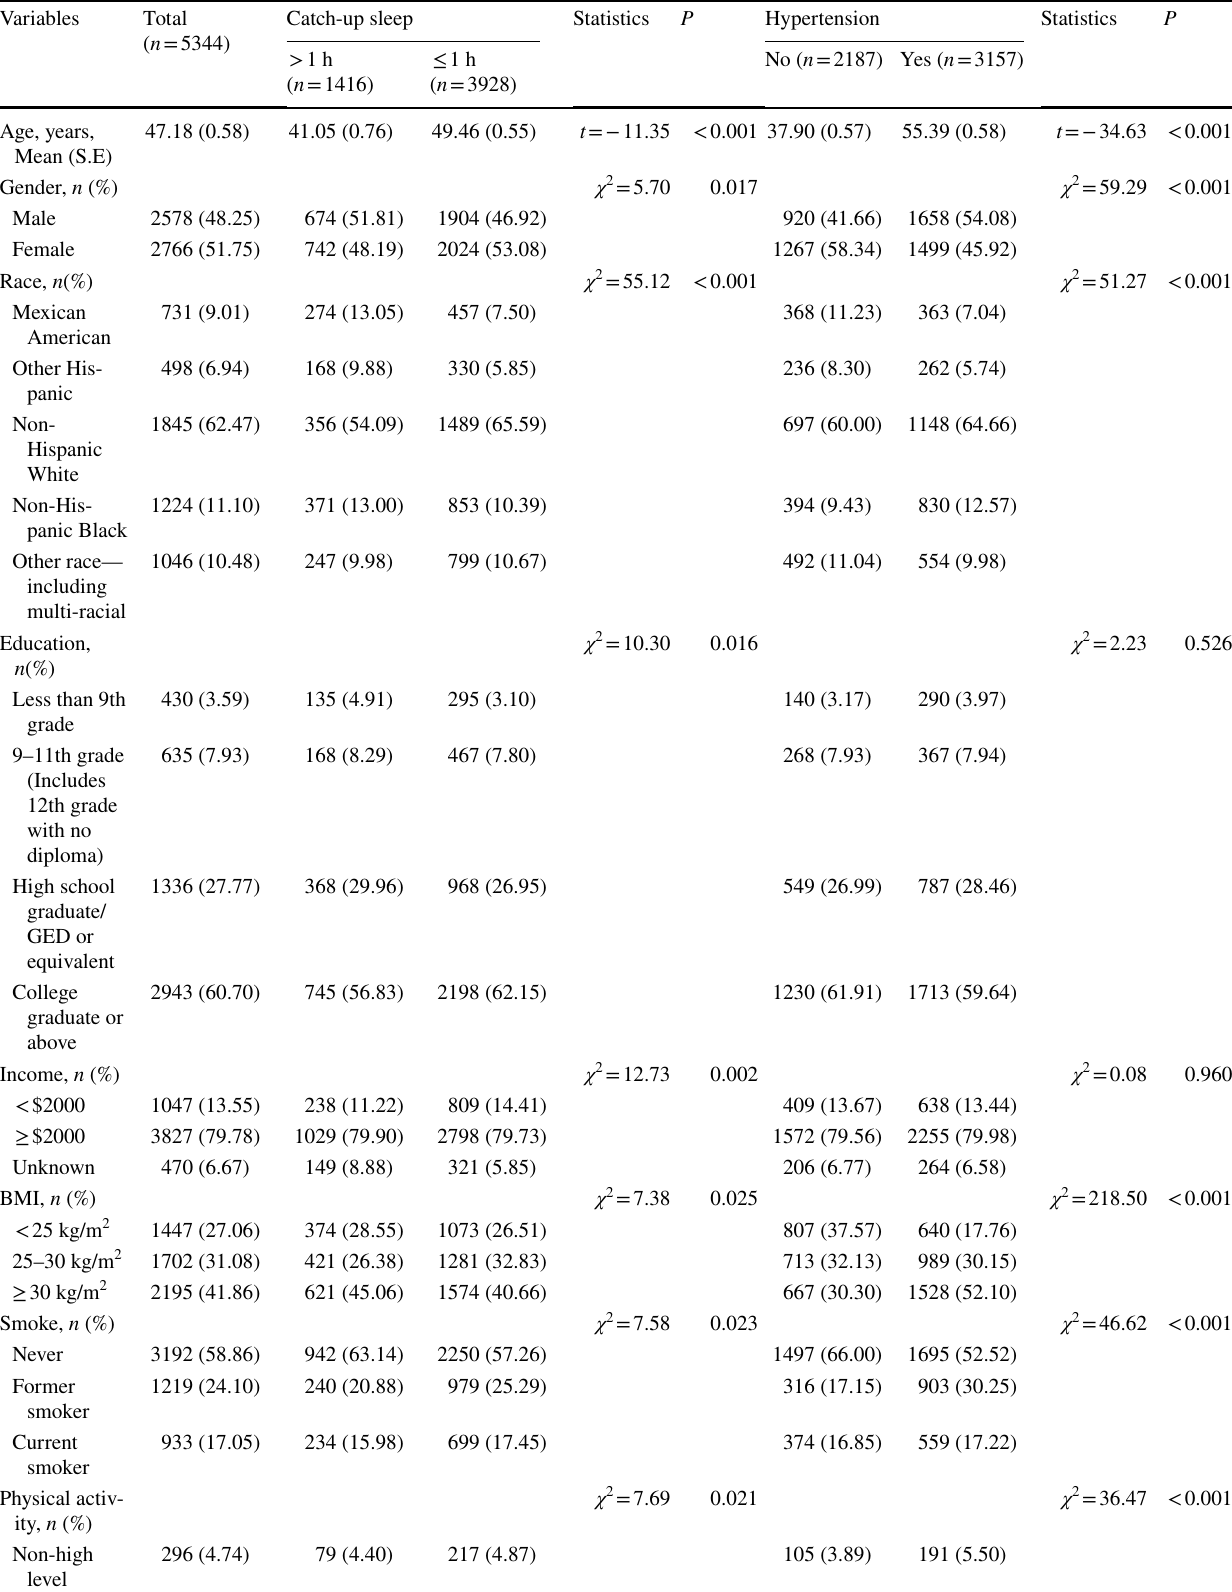
Table 1 The baseline characteristics of participants